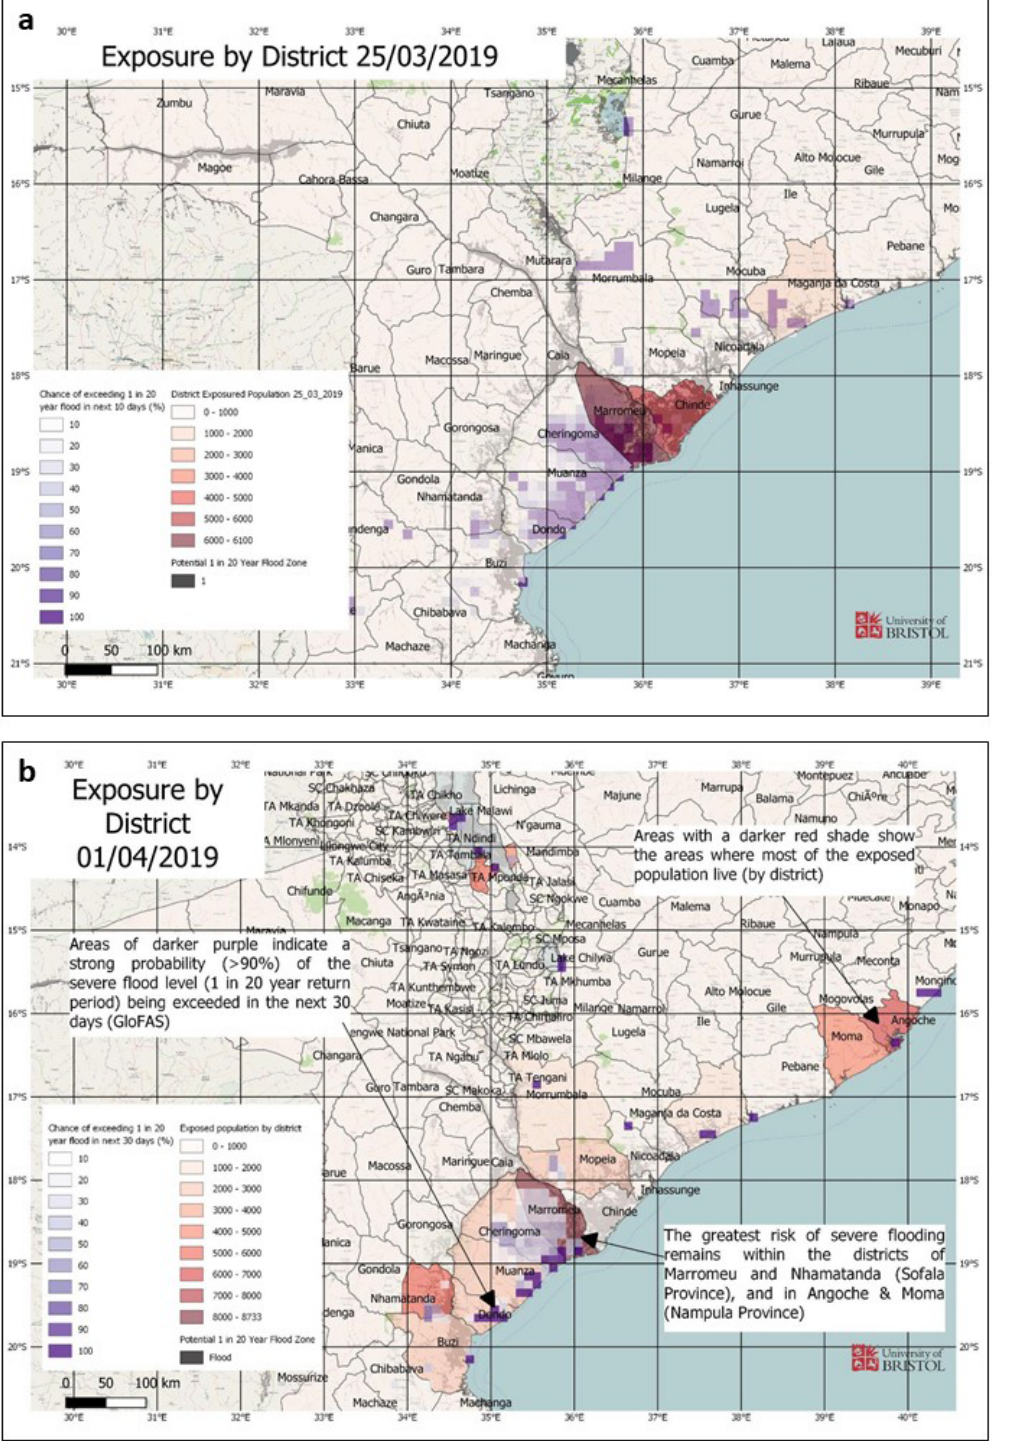
Figure 3. Changes to the cyclone bulletin figure showing exposure by district for Cyclone Idai between the report issued on 25 March (a) and the one issued on 1 April (b) ; note the addition of text to support interpretation (University of Bristol, 2019, flood exposure by district maps from the 25 March and 1 April 2019 cyclone reports created by the University of Bristol in response to Cyclone Idai, 2019, permission to reproduce the image granted by the University of Bristol, Jeffrey Neal, October 2021, images obtained from the flood hazard and risk emergency report received as part of personal communications received from the University of Reading, Linda Speight, August 2019).